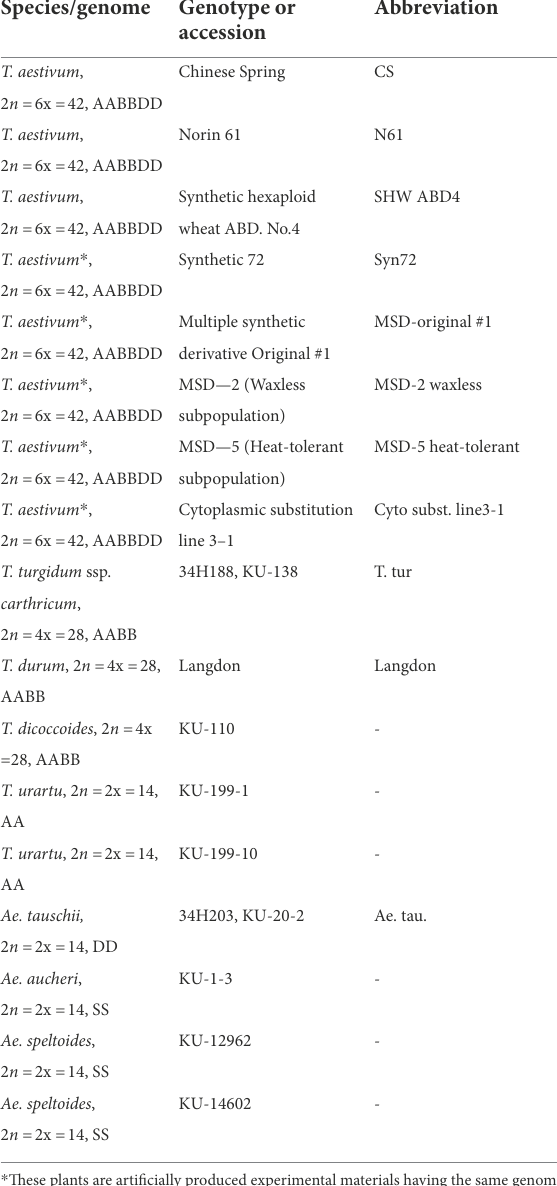
TABLE 1 List of plant materials used for the amplification and isolation of MITE fragments and study of the distribution of MITE insertions and evolutionary relationships in the Triticum–Aegilops